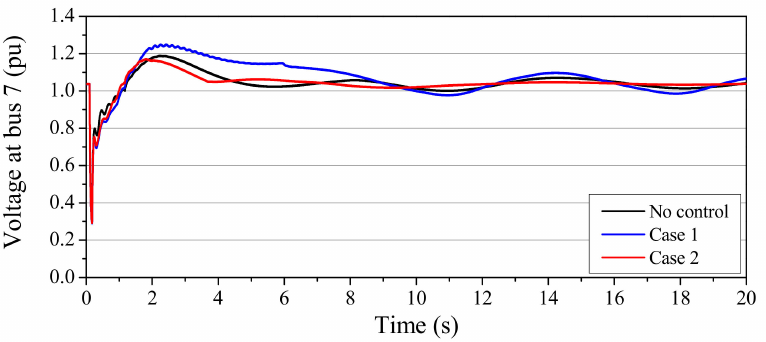
Figure 11. Voltage at bus 7 (with SG3